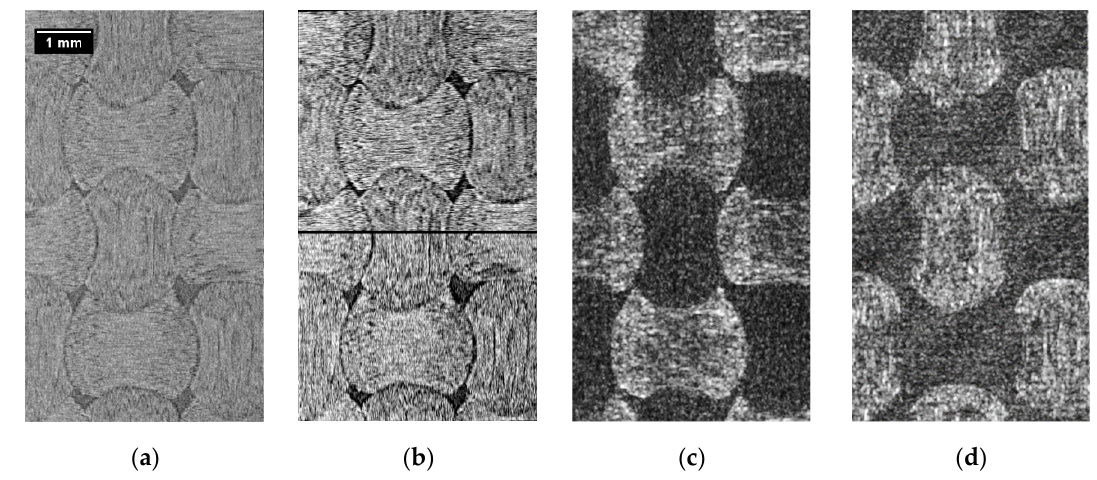
Figure 4. ( a ) Raw image; ( b ) Effect of the uniform filter for horizontal (top) and vertical (bottom) direction of the kernel; ( c ) Morphological gradient for vertical and ( d ) horizontal orientation of the line structure element.